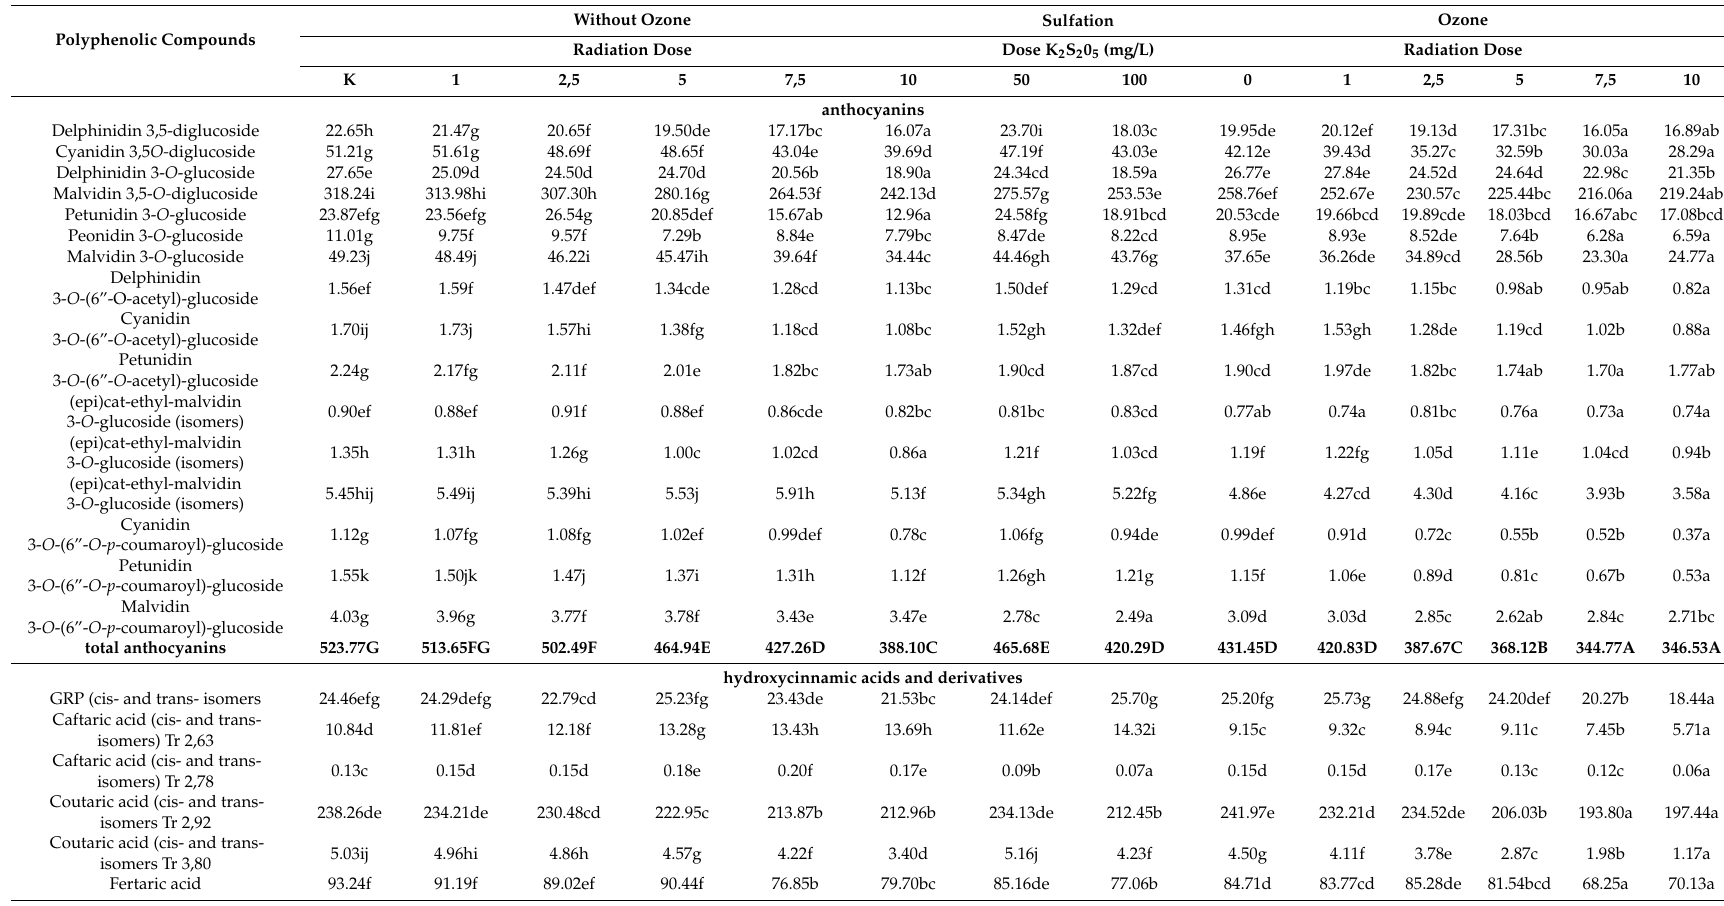
Table 4. Quantitative determination of polyphenolic compounds in wine depending on the method of microbiological stabilization (mg / L). Polyphenolic